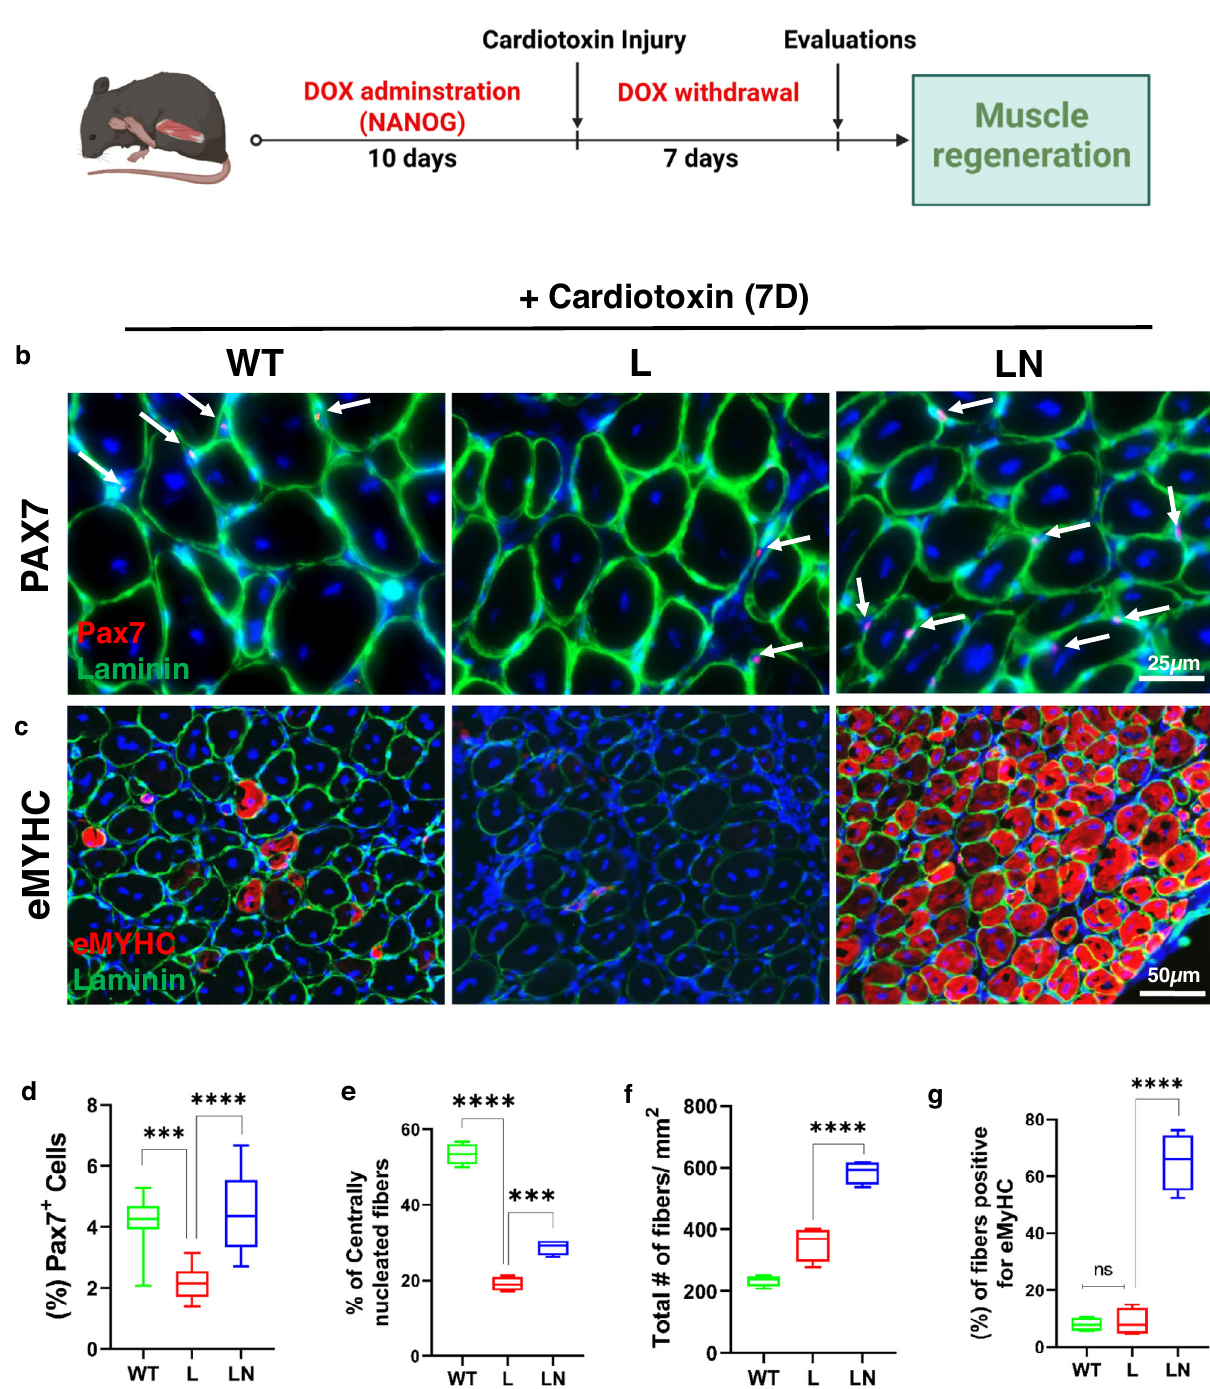
Fig. 7 | NANOG restores skeletal muscle regeneration of LAKI mouse muscle in vivo. a Graphic representation of the schedule for CTX injection and the experimentalprocedure. b , c Immunostaining for b Pax7 (red)and laminin(green) (Scale bar=25 μ m); c eMyHC (red) and laminin (green) (Scale bar=50 μ m) after 7 days of cardiotoxin injury. d Quanti fi cation of % Pax7+ cells. e Quanti fi cation of the number of centrally nucleated myo fi bers with more than two nuclei. f , g Quanti fi cation of the total number of fi bers f and number of fi bers positive for